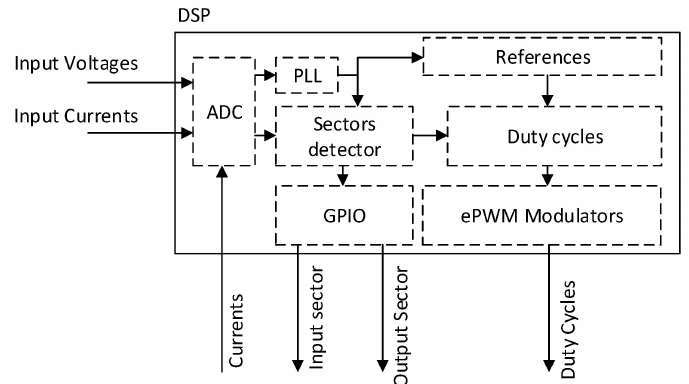
Figure 4. Block diagram of the DSP control algorithm.